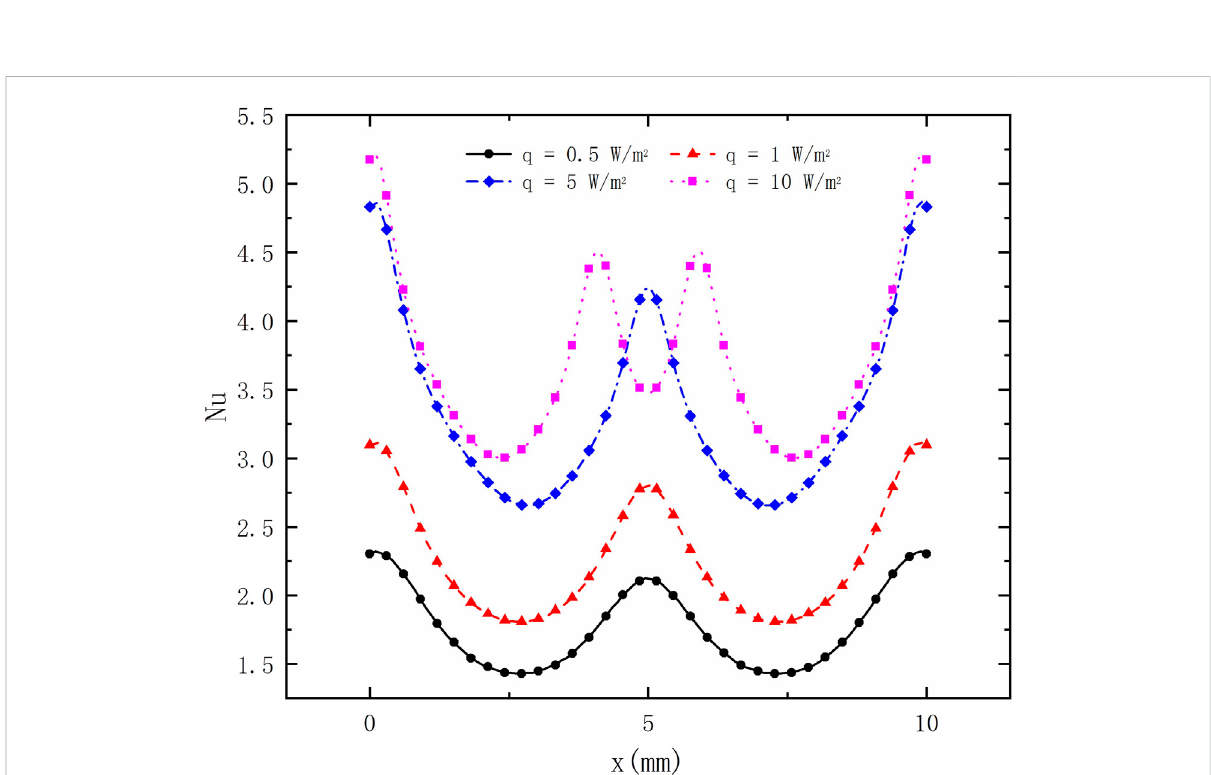
FIGURE 12 Distributions of the local Nusselt number Nu on the bottom wall at various heat fl